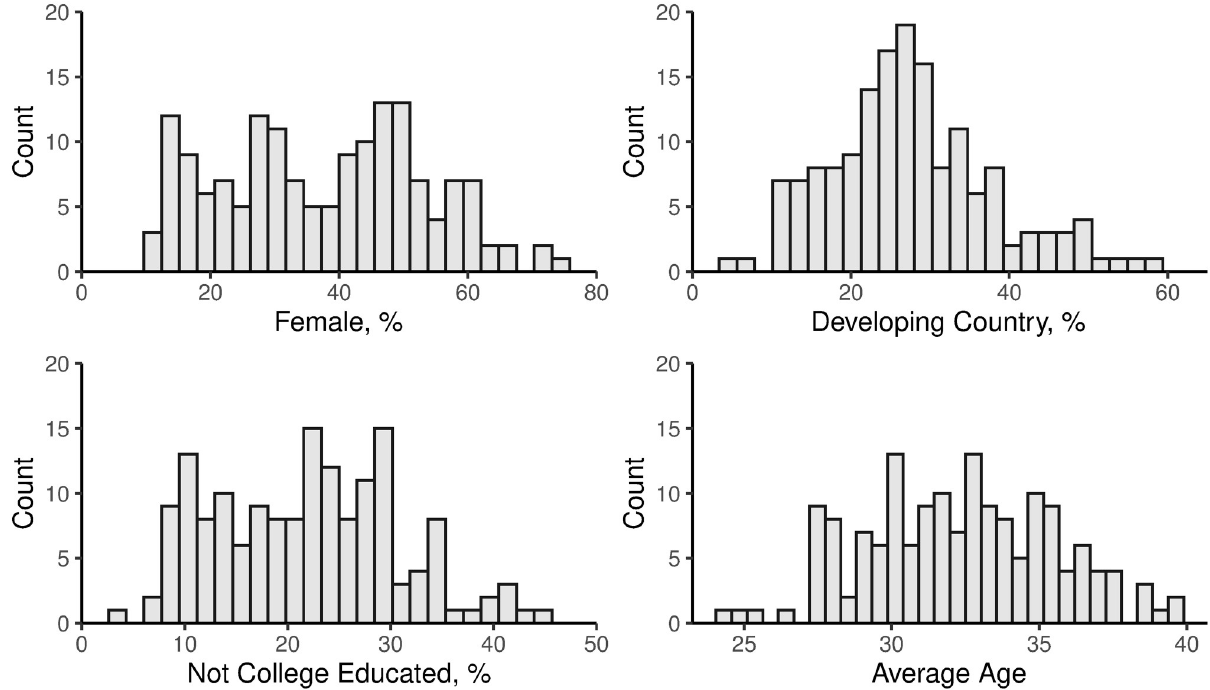
Fig 2. Course-level distributions of sociodemographic enrollment outcomes. Histograms showing the distribution of each measure of enrollment for the 159 courses in the Stanford and edX sample. The sample mean (and standard deviation) for each measure are 38% (16%) female, 28% (10%) from developing countries, 22% (8.9%) not college educated, and 32 (3.2) average age.